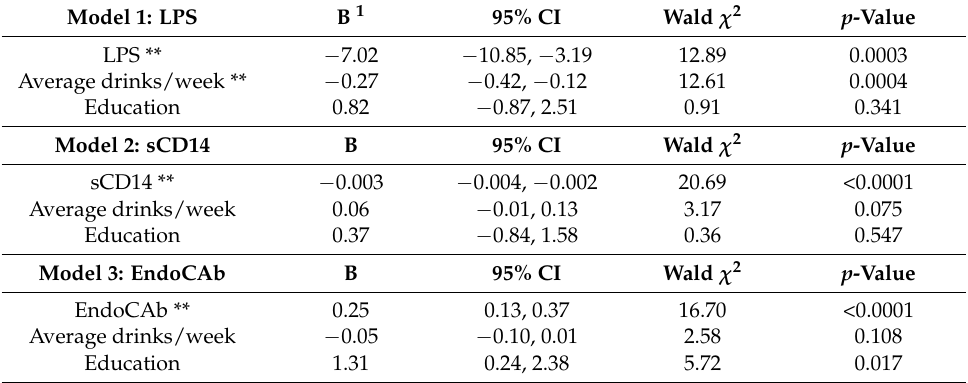
Table 2. Results of individual GEE models predicting processing speed (WAIS Digit Symbol test) using immune biomarkers, average weekly drinks, and education.